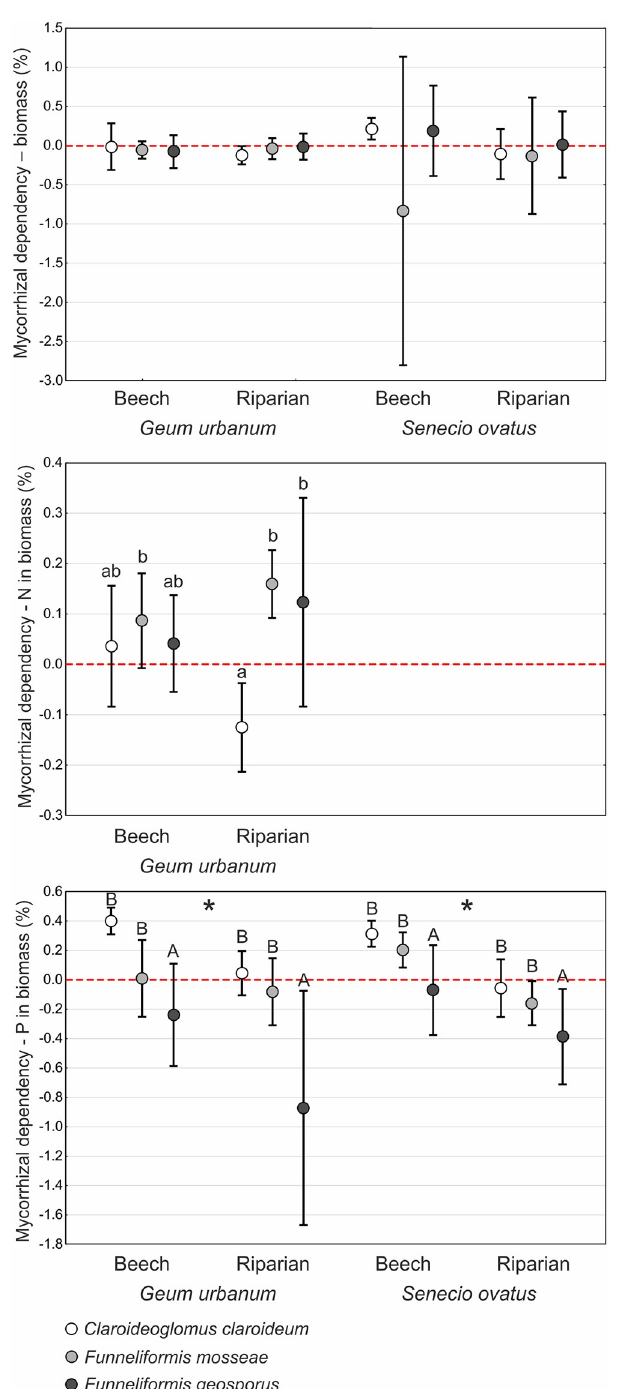
Fig 4. Mycorrhizal dependency parameters (percentages; mean ± SD) of values of mass of shoots and roots as well as of nitrogen and phosphorus contents in shoots and roots of Geum urbanum and/or Senecio ovatus grown in beech and riparian soils. Within each plant species, lowercase letters above the bars indicate statistically significant interaction between fungus and soil effects; uppercase letters indicate the significant main effect of fungus; different letters above the bars indicate statistically significant differences; the asterisk ( � ) indicates the significant main effect of soil; for each, p < 0.05. See Table 2 for details on the main effects and interactions.